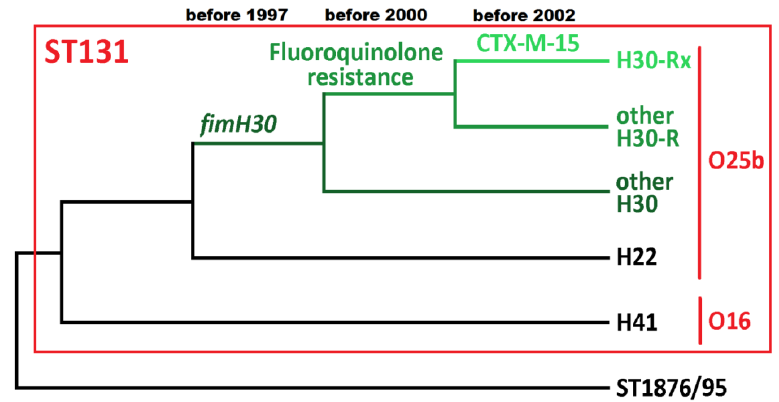
Figure 1. ST131 genetic groups and acquisition of drug-resistance changes. This cladogram shows ST1876 and ST95 as the most closely related clonal complexes to ST131 (with published genomes). H41 is in serotype O16:H5 and is Clade A (H41) [117]. H22 is a set of O25b:H4 ST131 called Clade B [117]. H30 is a subgroup of O25b:H4 ST131 defined by their acquisition of the fimH30 allele (dark green) [98]: this is Clade C. H30-R is a subset of H30 that are nearly always fluoroquinolone-resistant (emerald green) due to alleles have bla CTX-M-15 (bright green) [98] but not always [117]. This diagram does not mean that H30, H30-R or H30-Rx are monophyletic